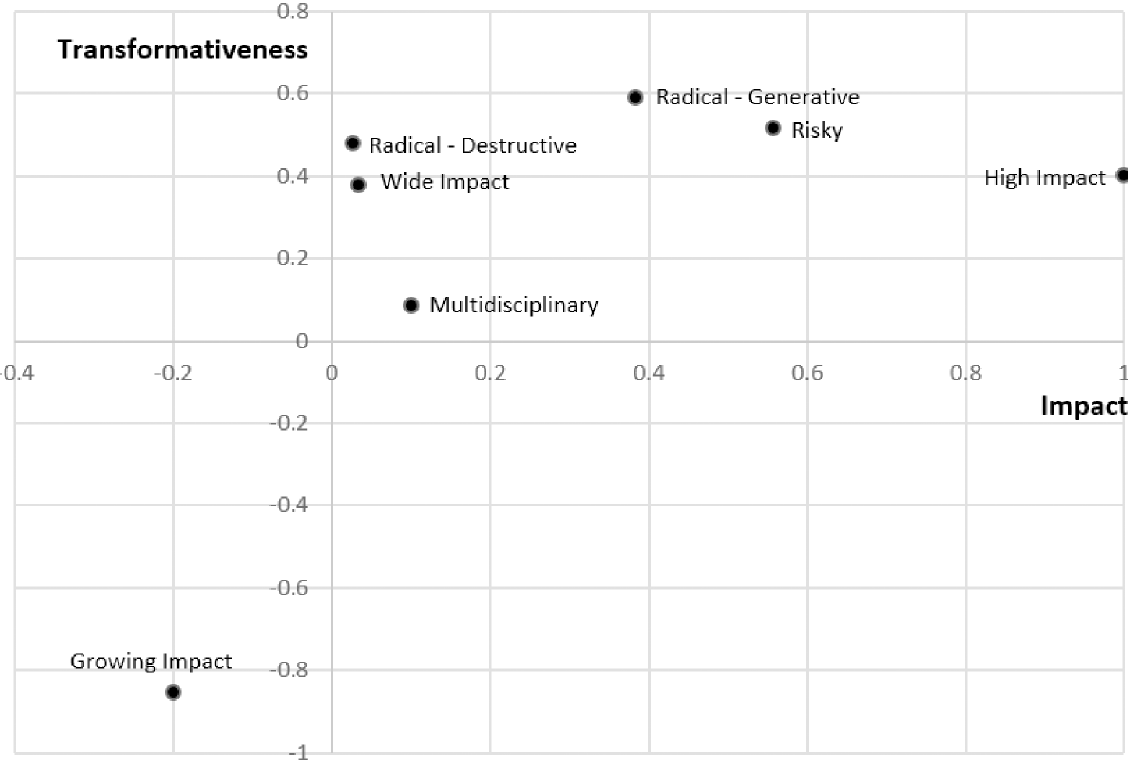
Fig 4. All seven aspects of HITS related to impact and transformativeness. The figure shows the partial correlations between the metrics for the aspects of transformative research and the overall metrics for transformativeness and impact across field-period pairs after eliminating variation across field and time (that is, time and field fixed